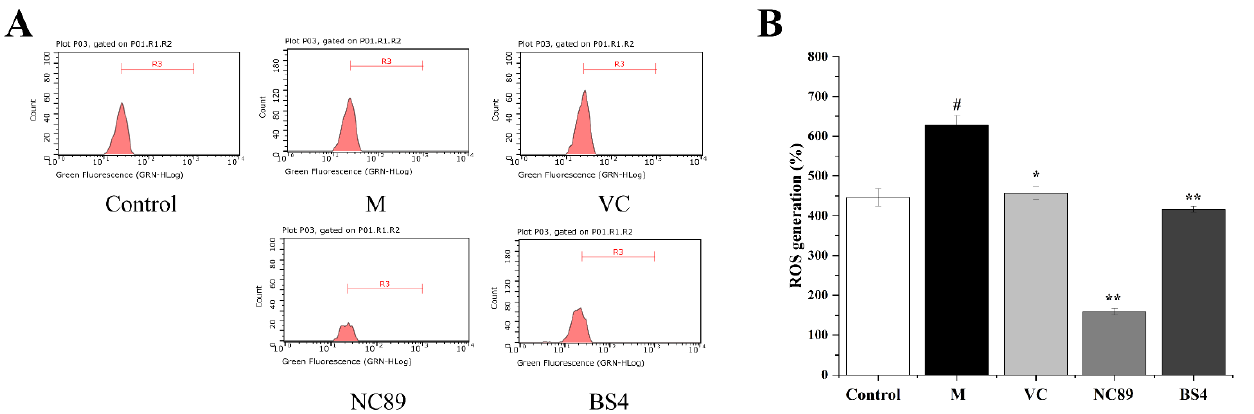
Figure 3. NC89 and BS4 tobacco seeds oil mitigated reactive oxygen species’ (ROS) accumulation in HepG2 cells induced by H 2 O 2 . ( A ): Flow cytometry analysis; ( B ): the intracellular ROS content. Values are presented as the mean ± SD ( n = 3). # p < 0.05 vs. Control group; * p < 0.05, ** p < 0.01 vs. M group.